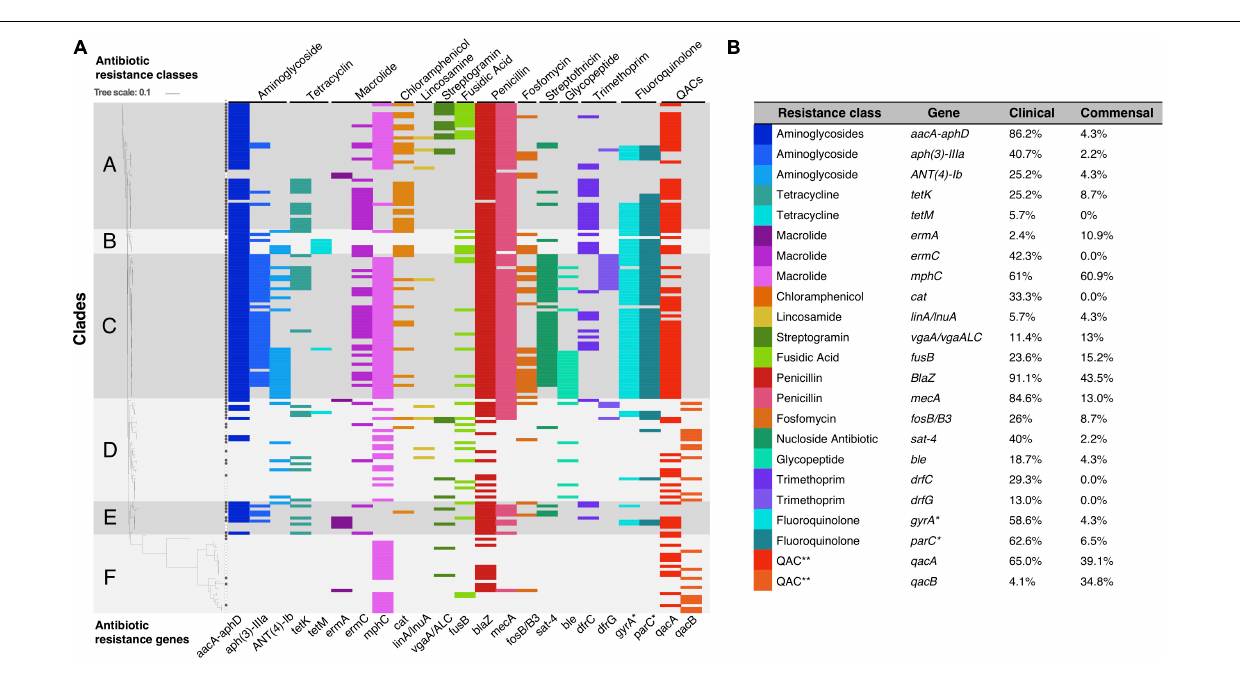
FIGURE 3 | (A) Graphical representation of S. haemolyticus antibiotic resistance genotype plotted onto the phylogenetic SNP-based core tree. The figure shows the presence and absence of ARGs and classes across the different clades. ∗ Mutations in gyrA and parC gives resistance to fluoroquinolones. ∗∗ QACs: quaternary ammonium compounds. (B) The percentage of each ARG present in the clinical and commensal